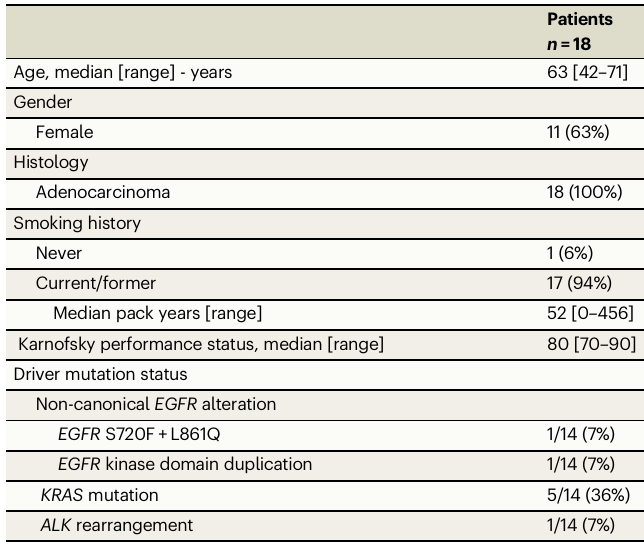
Table 1 | Baseline clinicopathologic characteristics